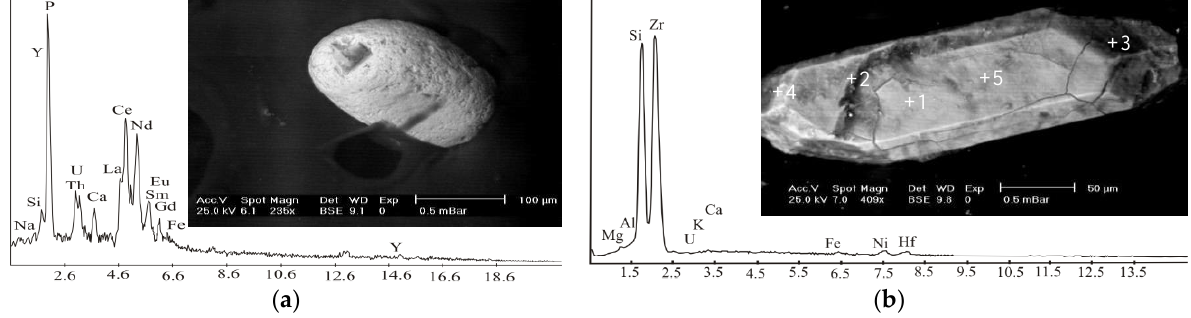
Figure 4. Back-scattered electron (BSE) images and EDS chart for ( a ) monazite; ( b ) zircon from monzogranite at Monqul, north Eastern Desert, Egypt.